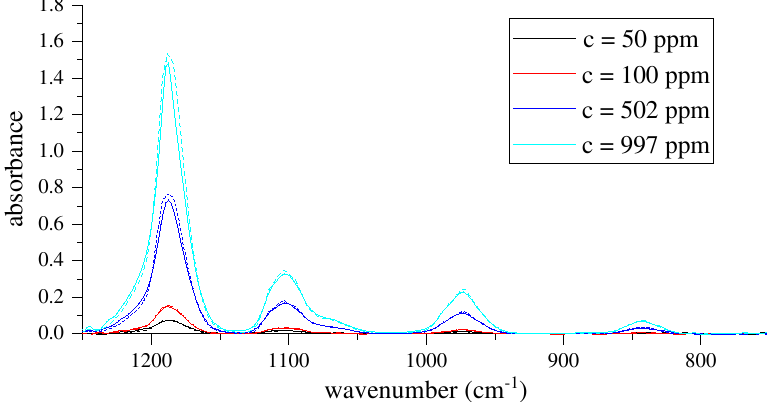
Figure 4. Recorded R134a absorption spectra with different concentrations by the sSMFTS system (solid lines) and the corresponding reference spectra measured with a conventional FTIR spectrometer (dashed lines) at a spectral resolution of 8 cm − 1 . All spectra were measured at an optical path length of 80